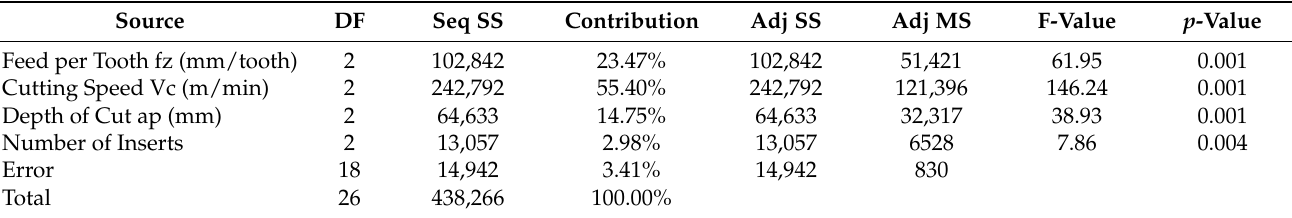
Table 6. ANOVA results for specific cutting energy.